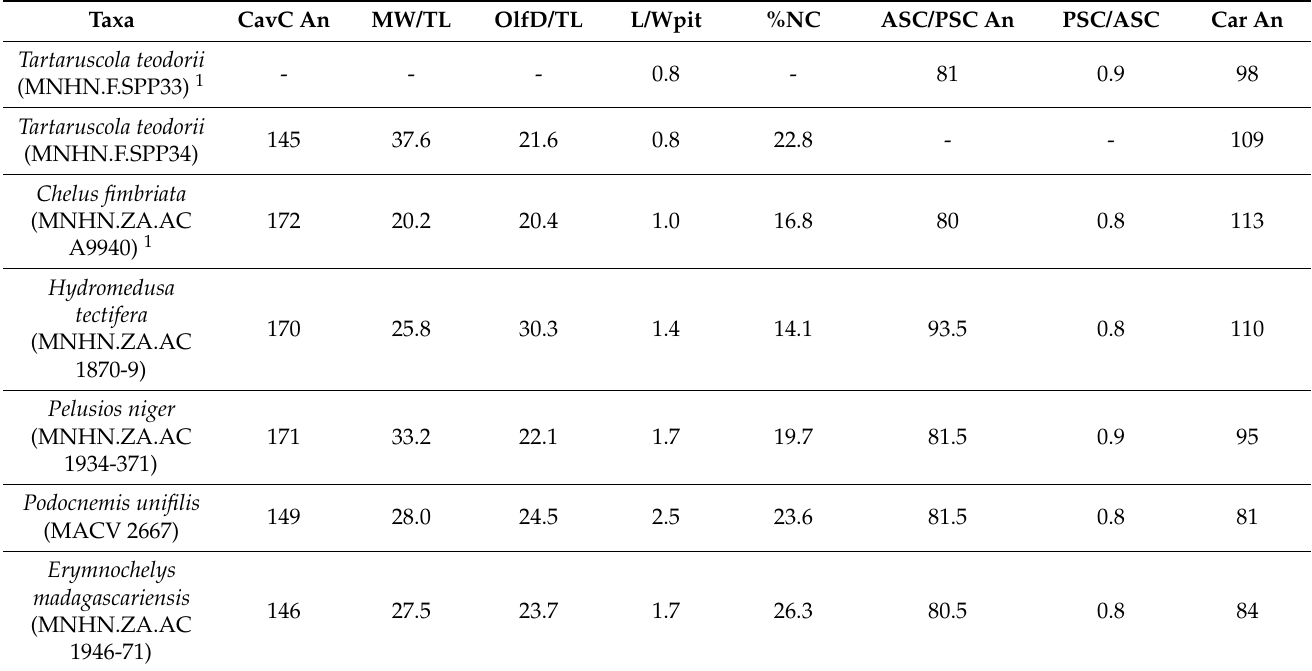
Table 1. Angles and ratios corresponding to the measurement of the pleurodiran taxa studied